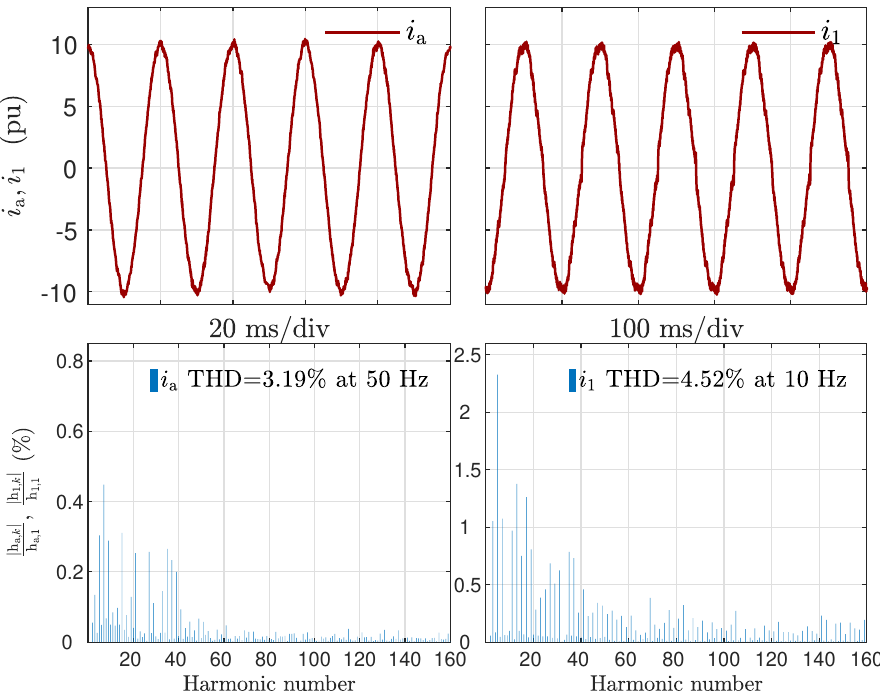
Figure 24. Spectrum of i a , i 1 and THD results, when PD–SPWM modulation technique is